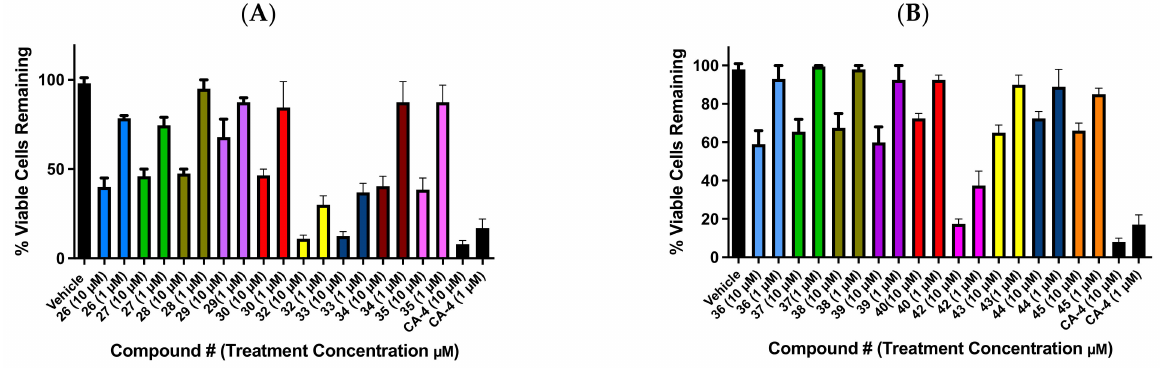
Figure 3. Preliminary cell viability data for 3-fluoro and 3,3-difluoro β -lactam compounds. ( A ) 3- Fluoro β -lactam compounds containing different para -substituent ring B 26 – 29 ; 3-fluoro β -lactam compounds containing different meta -substituent ring B 30 , 32 – 35 ; ( B ) 3-difluoro β -lactam com- pounds containing different para -substituent ring B 36 – 39 ; 3-difluoro β -lactam compounds containing different meta -substituent ring B 40 , 42 – 45 in MCF-7 breast cancer cells. Cell proliferation of MCF-7 cells was determined with an AlamarBlue assay (seeding density 2.5 × 10 5 cells/mL per well for 96-well plates). Compound concentrations of either 10 µ M or 1 µ M for 72 h were used to treat the cells with control wells containing vehicle ethanol (1% v / v ) and CA-4 (10 µ M and 1 µ M). The mean value for three experiments is shown with the ± S.E.M. for three independent